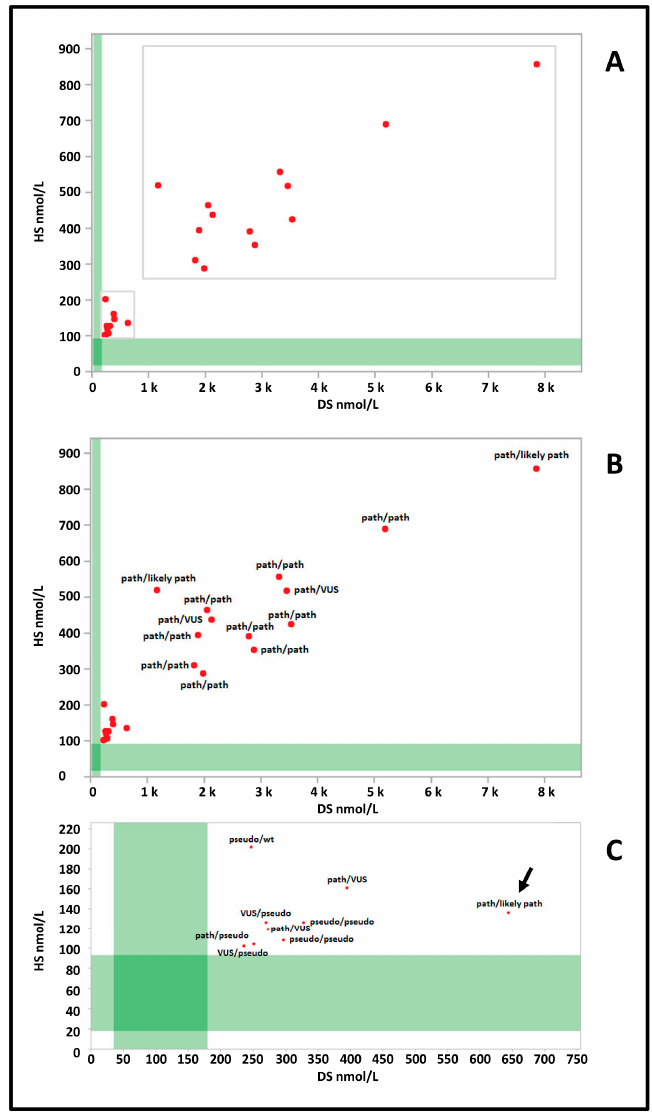
Figure 2. ( A ) Dermatan (DS) and heparan (HS) sulfate values of group 3 cases (red dots) are plotted against the reference population (green bands) (DS n = 3113; HS n = 3165). ( B ) IDUA genotypes of cases with higher levels of both DS and HS. ( C ) IDUA genotypes of cases with lower levels of DS and HS. path: pathogenic variant; likely path: likely pathogenic variant; VUS: variant of unknown significance; pseudo: pseudo deficiency allele; wt: wild type.